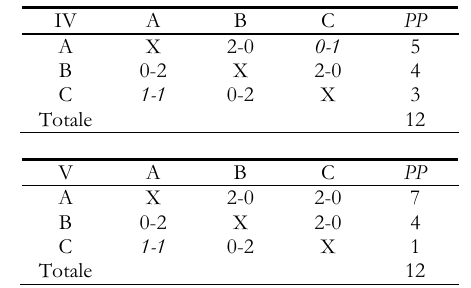
Griglia (partite sorpresa in carattere corsivo; PP=punti